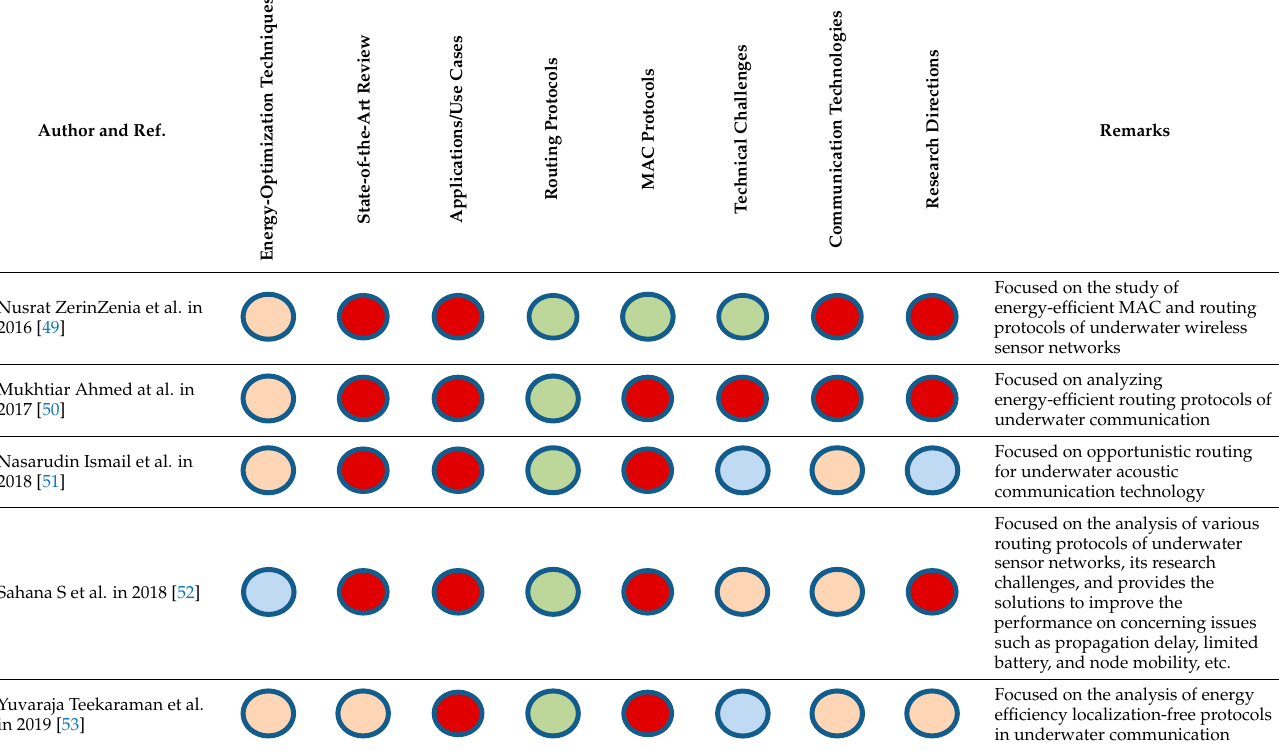
Table 2. Summary of recent surveys concerning energy-optimization techniques in UIoT.